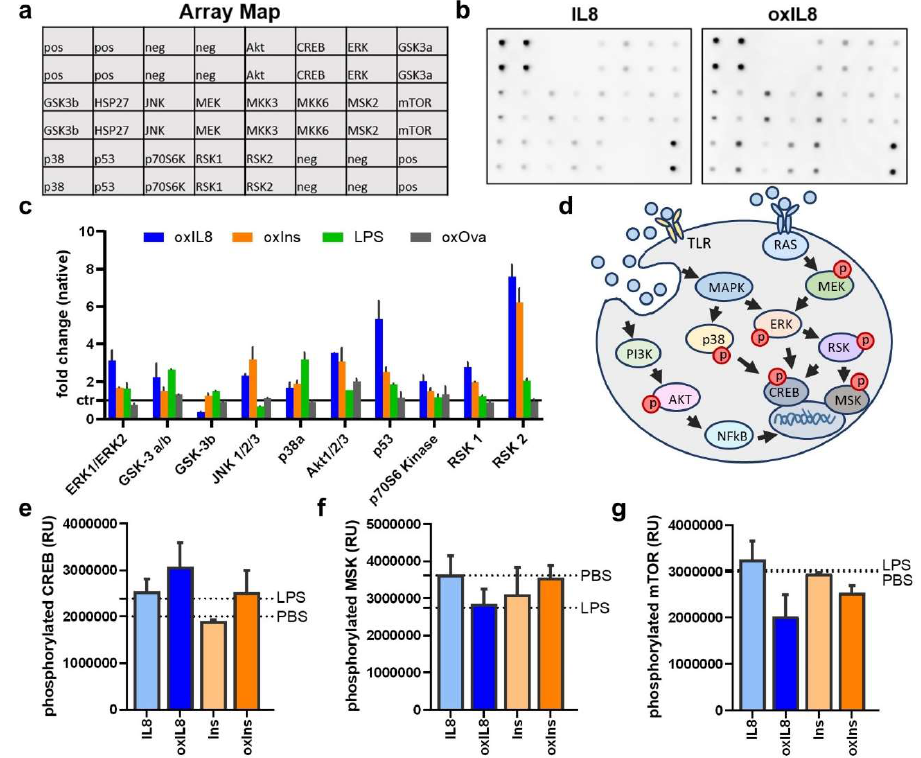
Figure 5. Gas plasma-treated insulin and IL8 reveal different modes of action in signaling cascades. ( a , b ) IL8 and insulin were chosen for phosphorylation assay (upper panel: antibody loading ( a ); lower panel: representative membranes ( b )); ( c ) phosphorylation state of signaling proteins after